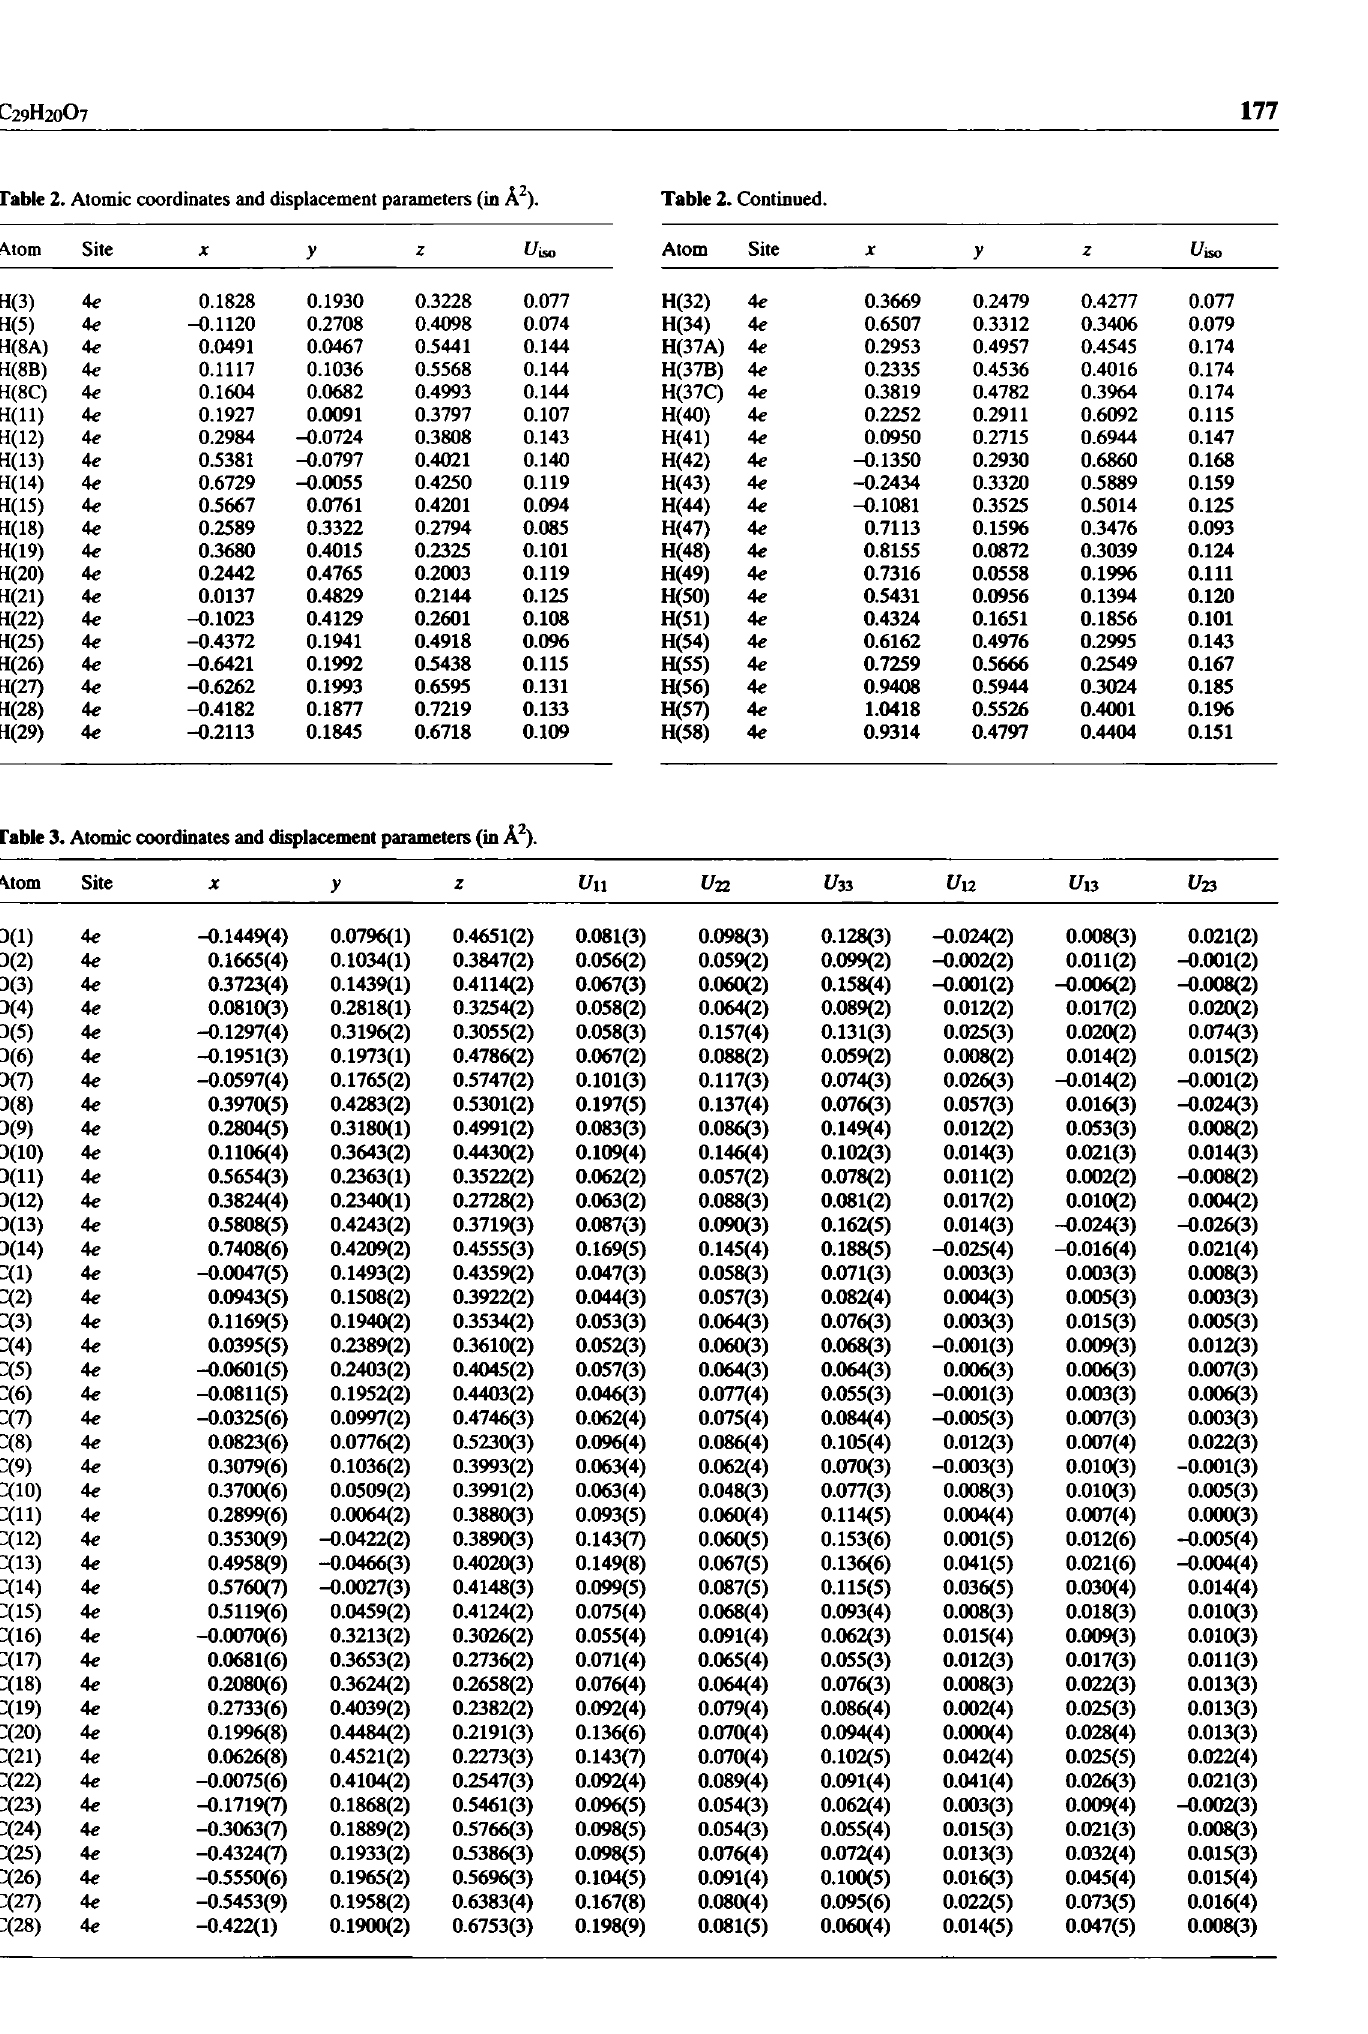
Table 3. Atomic coordinates and displacement parameters (in A 2